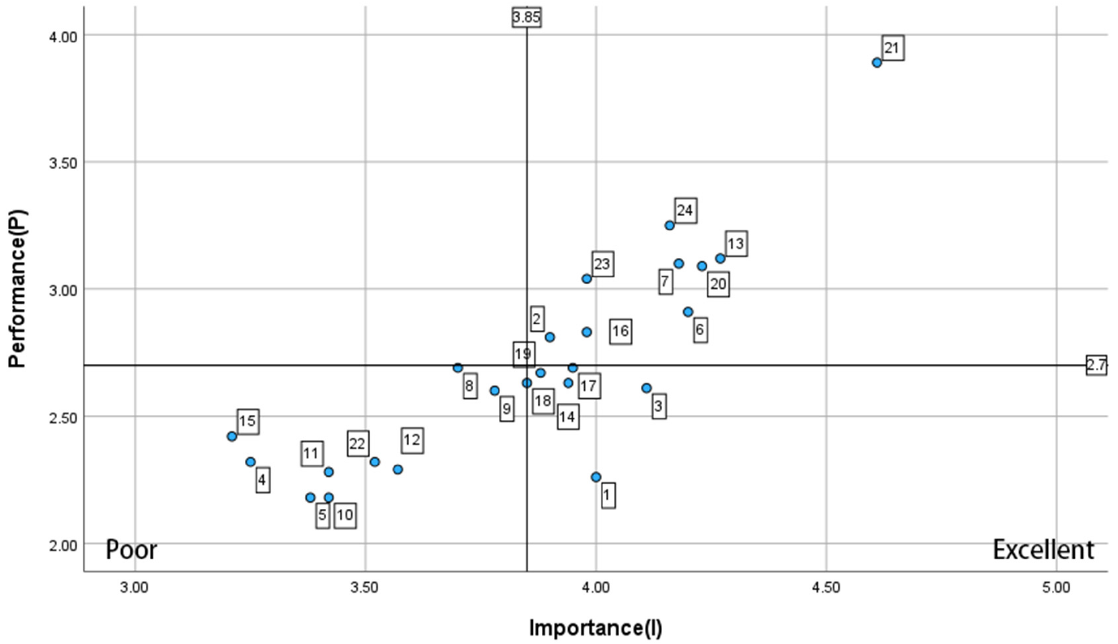
Figure 3. IPA matrix of items at the second level of classification. Note: 1. Official website function; 2. Online information access; 3. Event notice; 4. Message notification (e-mail from Tokyo Zoonet); 5. Electronic claim system; 6. Electronic ticket system; 7. Online booking; 8. Tourism blog; 9. Animal introduction platform; 10. VR sightseeing; 11. 3D models; 12. Application; 13. Digital map; 14. Sightseeing route recommendation; 15. Stamp; 16. Obtaining information from QR code; 17. Animal information service; 18. Smart guide system; 19. Tourist spots recommendations; 20. Free Wi-Fi; 21. Digital payment; 22. Fundraising; 23. Electronic information screen; 24. Animal state observation (Monitoring).